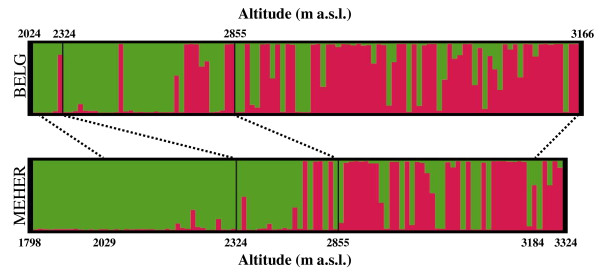
Population structure across seasons and altitudes using STRUCTURE. STRUCTURE assignment at K = 2 for the 108 individuals collected during the Belg growing season and the 104 individuals collected during the Meher season, ordered according to crescent altitude levels. Green, cluster S1; red, cluster S2.